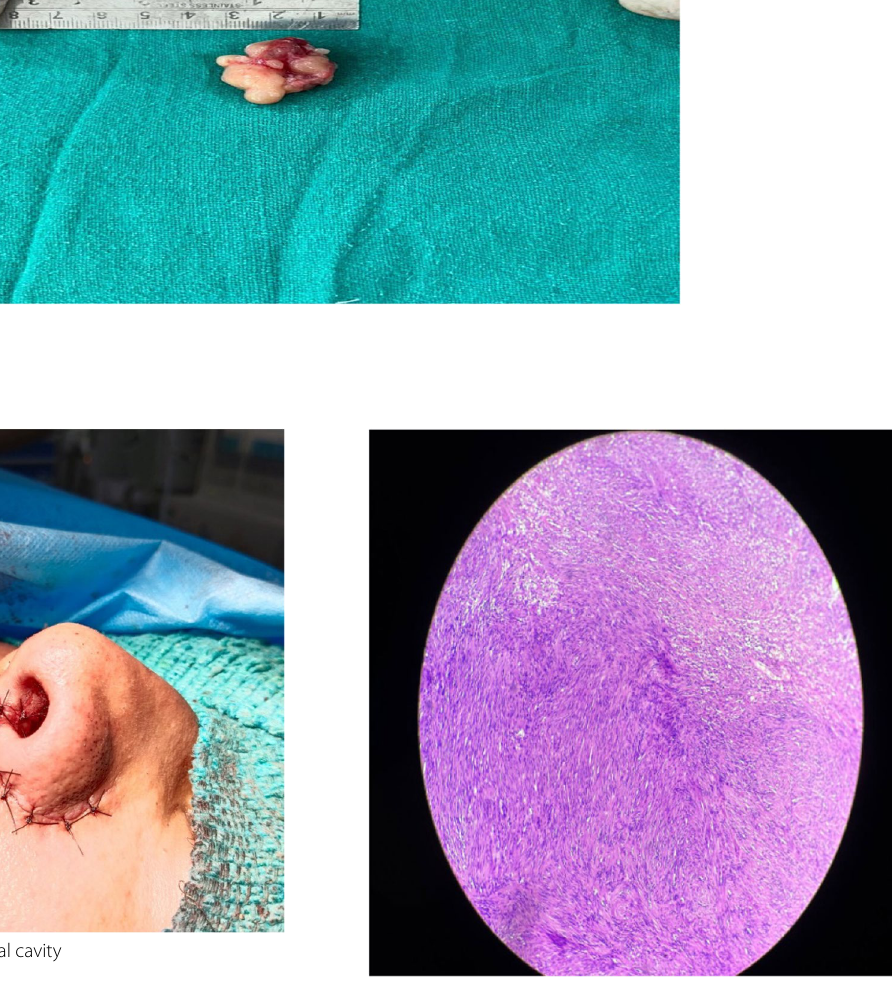
Discussion Schwannomas are rare, benign, slow-growing tumors aris- mation of the myelin sheath. Twenty-five to 45% of tumors from the nasal cavity and paranasal sinuses [6, 7]. Only 20 cases of nasal schwannoma have been reported to date.